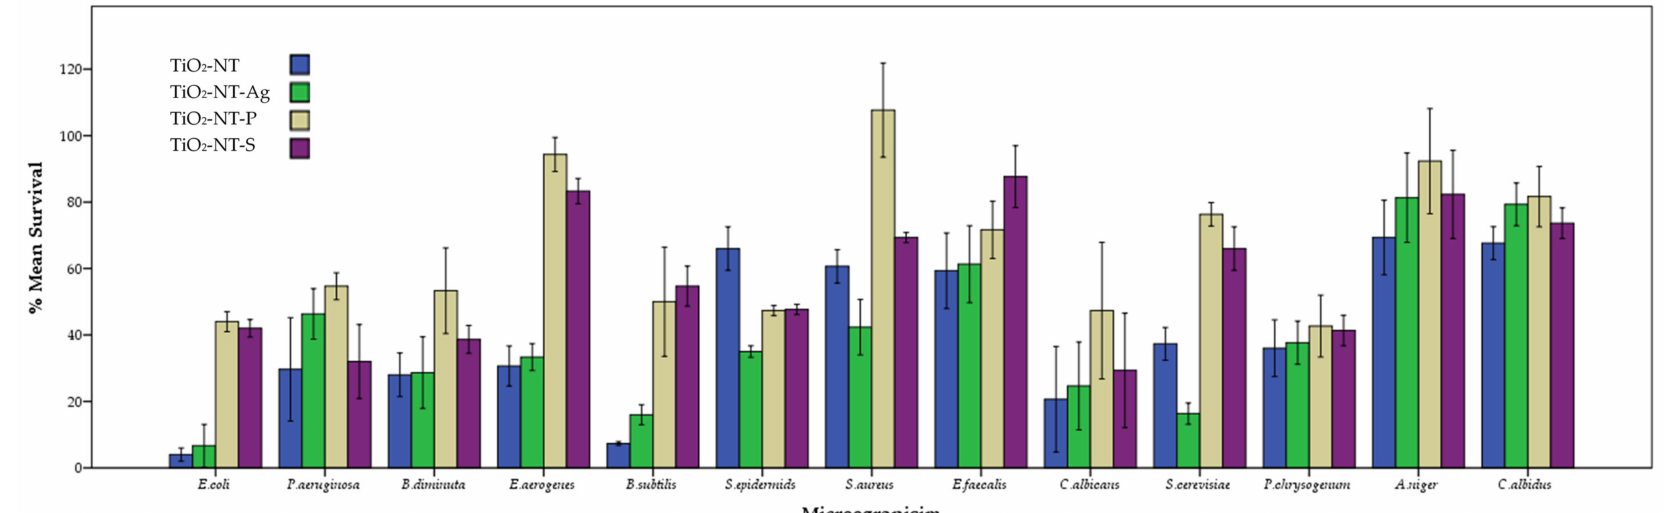
Figure 8. Percentage survival rate of various microorganisms belonging to Gram-negative and Gram-positive bacteria, fungi and yeast after being exposed for 1 h to di ff erent surface morphologies and UV radiation at 10 mWcm − 2